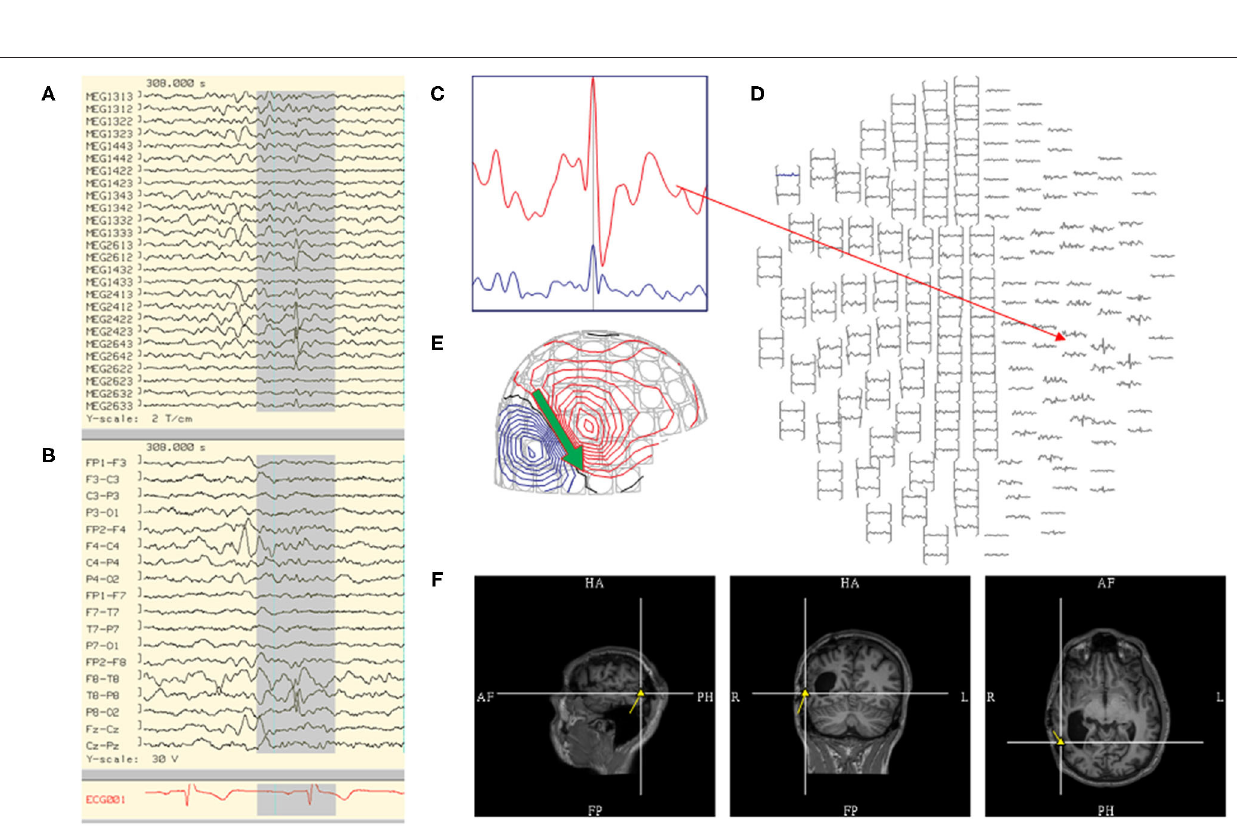
FIGURE 2 | Steps in the analysis of an MEG spike include reviewing: (A) MEG tracing, (B) EEG tracing, (C) MEG signal selection from (D) magnetic isofield map, (E) dipolar electro-magnetic field pattern where the primary current is represented by an arrow (green), and (F) localization through sECD method yielding a dipole model (yellow) that is coregistered to